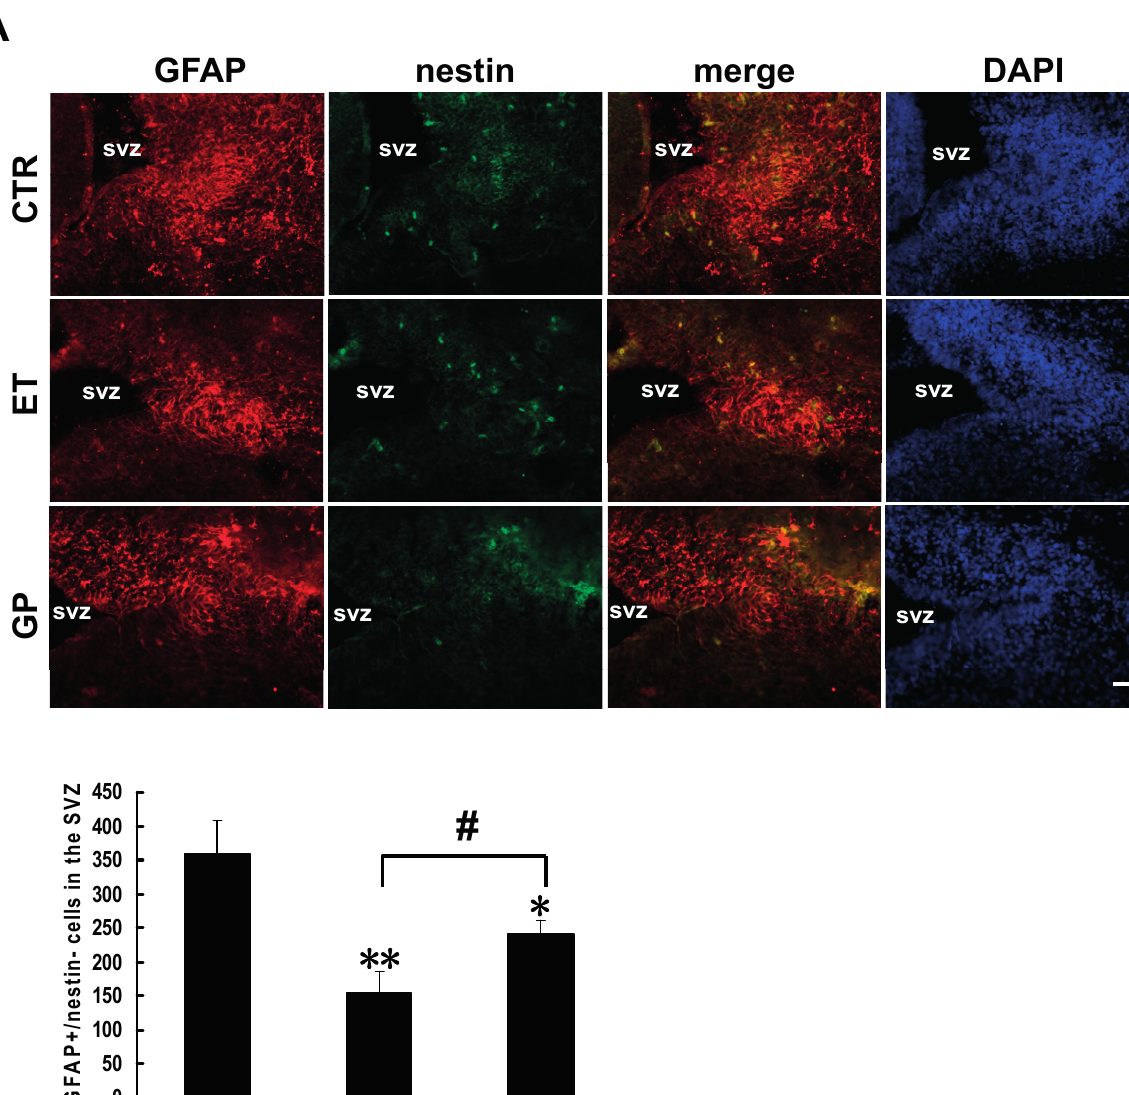
Figure 4. GPs increase the number of GFAP+/nestin- cells in the SVZ of the neonatal brain that was inhibited by ethanol. ( A ) Immunohistochemical double staining for GFAP (red) and nestin (green) was labeled in the SVZ of neonatal FASD rats. DAPI (blue) labeled all nuclei. Scale bar = 50 μ m; ( B ) Quantitative analysis of the number of GFAP+/nestin- cells in the SVZ. * p < 0.05 and ** p < 0.01 vs. CTR; # p < 0.05 vs. ET